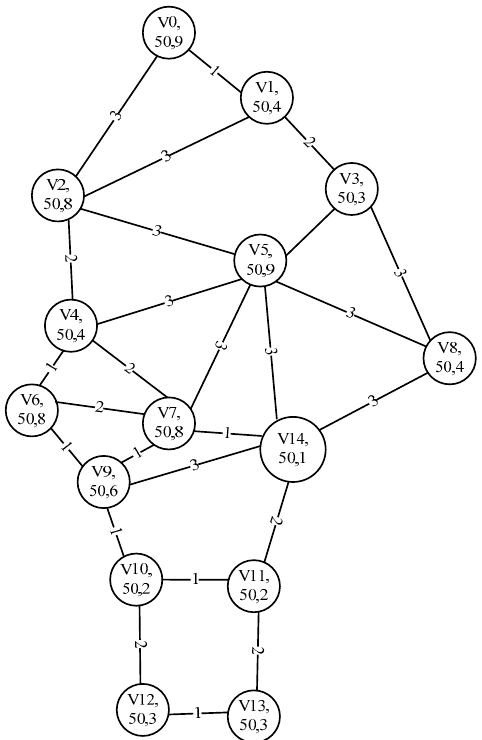
Figure 2. The network topology of Figure 1.